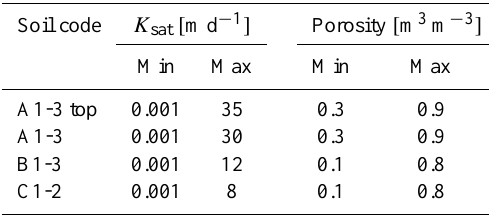
Table 3. Modeling periods. Table 4. Soil parameter ranges for the Monte Carlo simulations (as- suming uniform distribution for each